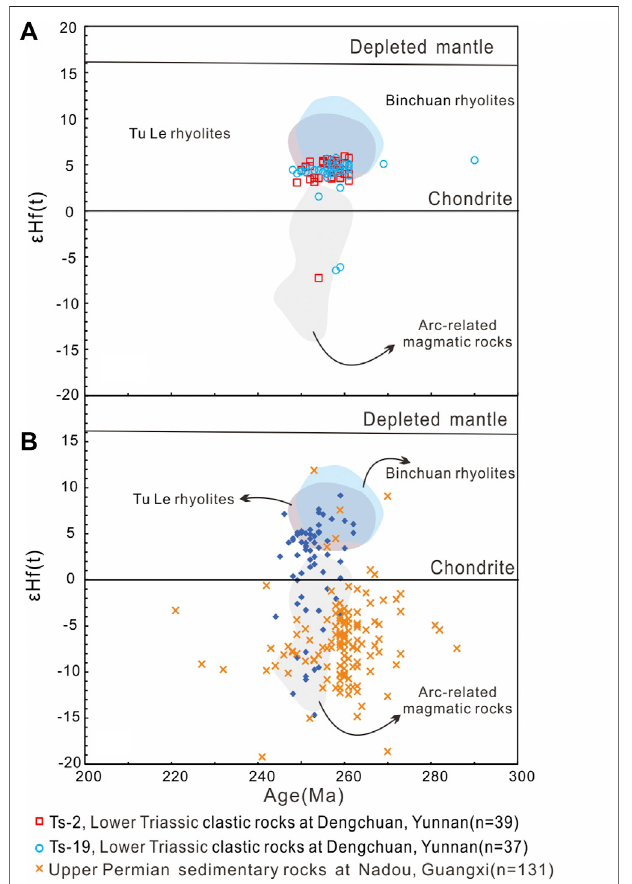
FIGURE 10 | (A,B) Plot of ε Hf (t) values vs. U-Pb ages for zircons. Date from Upper Permian sedimentary rocks at Nadou (Hou et al., 2017), Lower Triassic clastic rocks at Gejiu and Jinping areas (Xu et al., 2019), Tu Le and Binchuan rhyolites (Usuki et al., 2015; Huang et al., 2022a), and arc- related magmatic rocks from Hainan Island, southern Yunnan and Guangxi provinces (He et al., 2018; Shen et al., 2018; Wang et al., 2021) are shown for comparison. The depleted mantle evolution line data are from Blichert-Toft and Albarède, (1997) and Grif fi n et al. (2000).